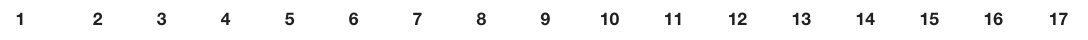
TABLE 1 | Correlations between all measures at the